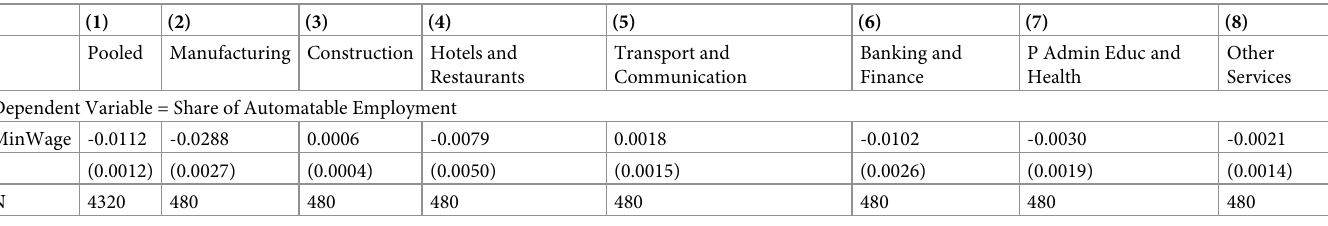
Table 2. Shares of employment